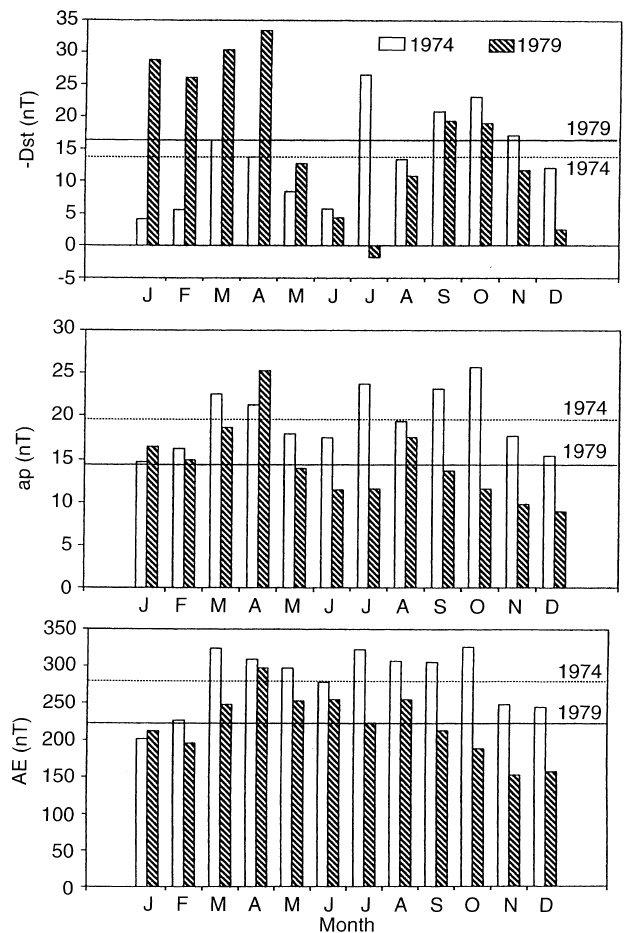
Fig. 2. Monthly averages of AE, ap and ) Dst; the annual averages are marked with solid (1979) and dashed (1974) horizontal lines